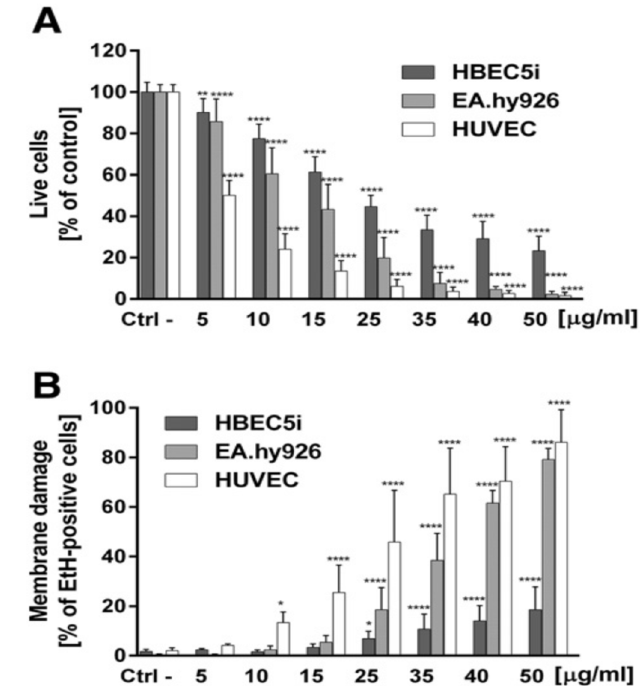
Figure 19. ( A ) Cell viability and ( B ) membrane damage of HBEC5i, HUVEC and EA.hy926 cells vs AgNPs concentrations after 24 h exposure to nanoparticles. Data are presented as means ± SD. * p < 0.05; ** p < 0.01; **** p < 0.0001. Reproduced from [59] with permission of Elsevier.